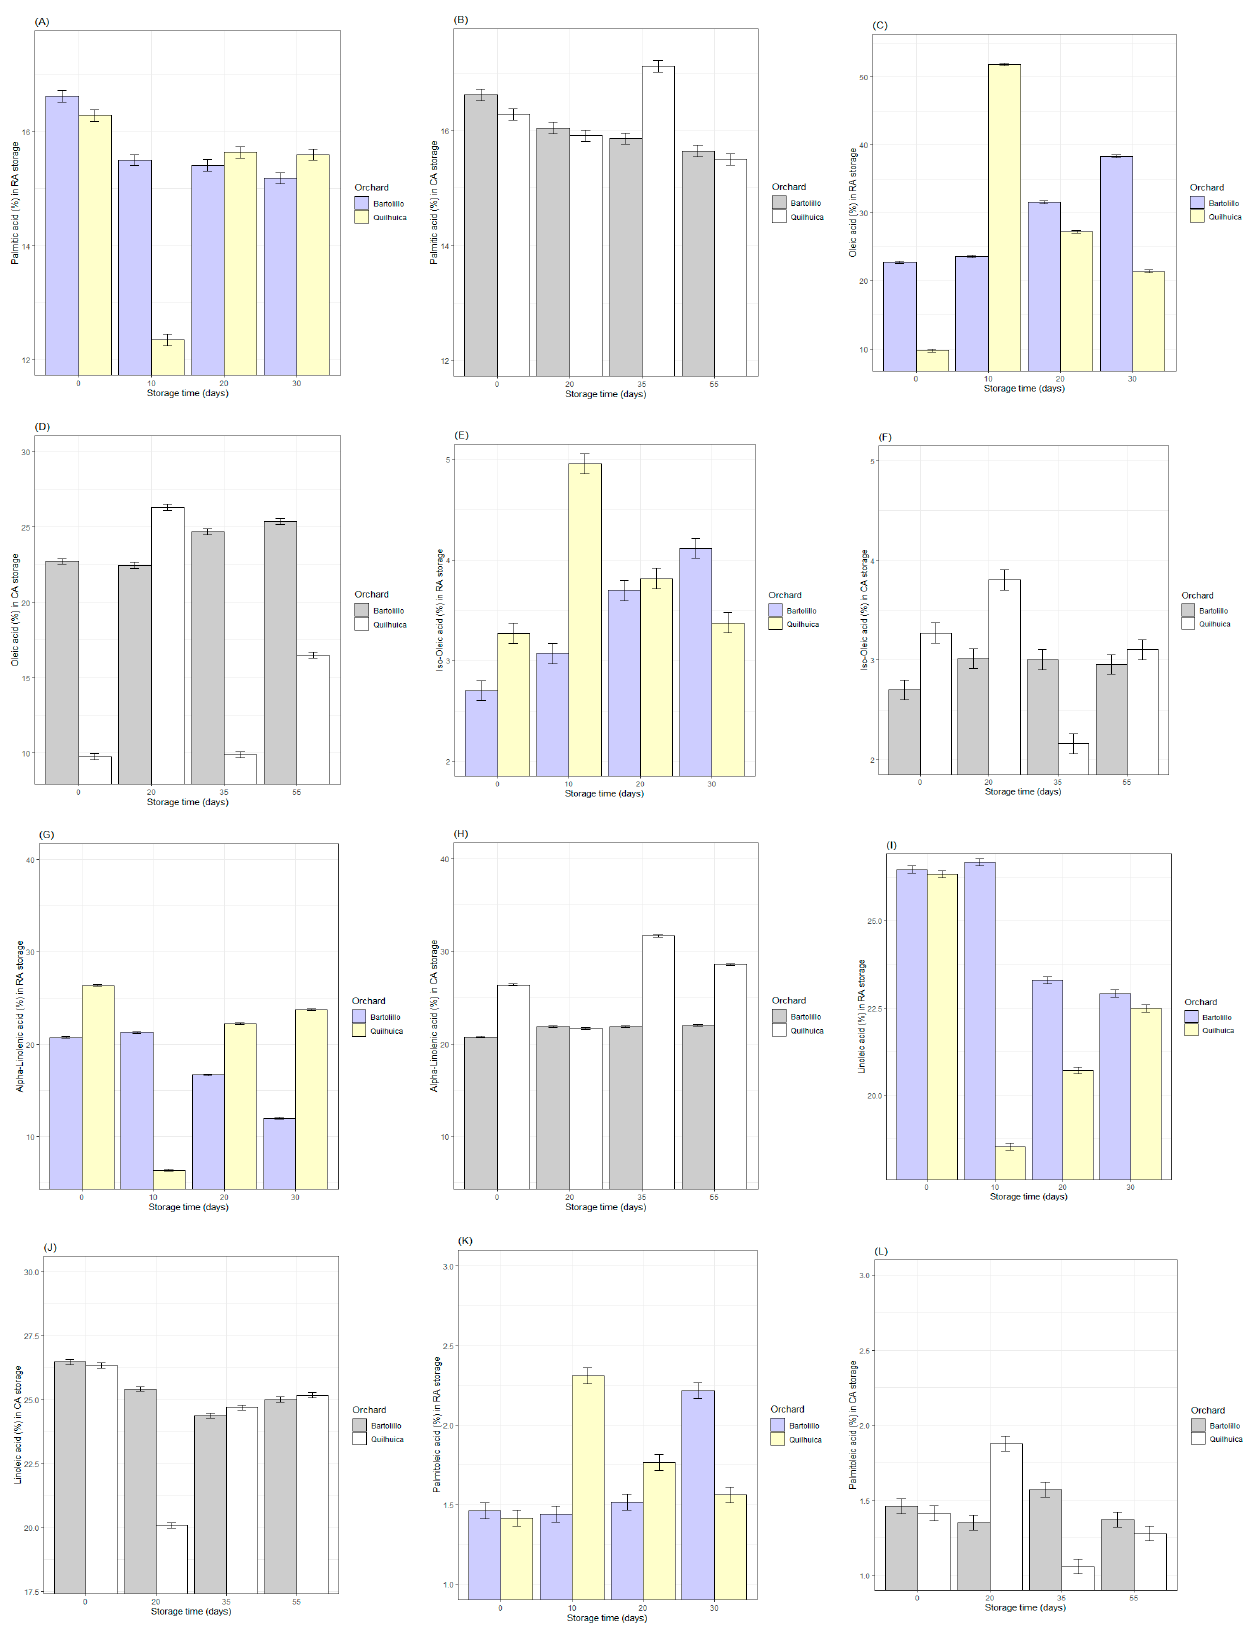
Figure 2. ( A – L ): Changes in fatty acids during two different storage conditions intwo Hass avocado